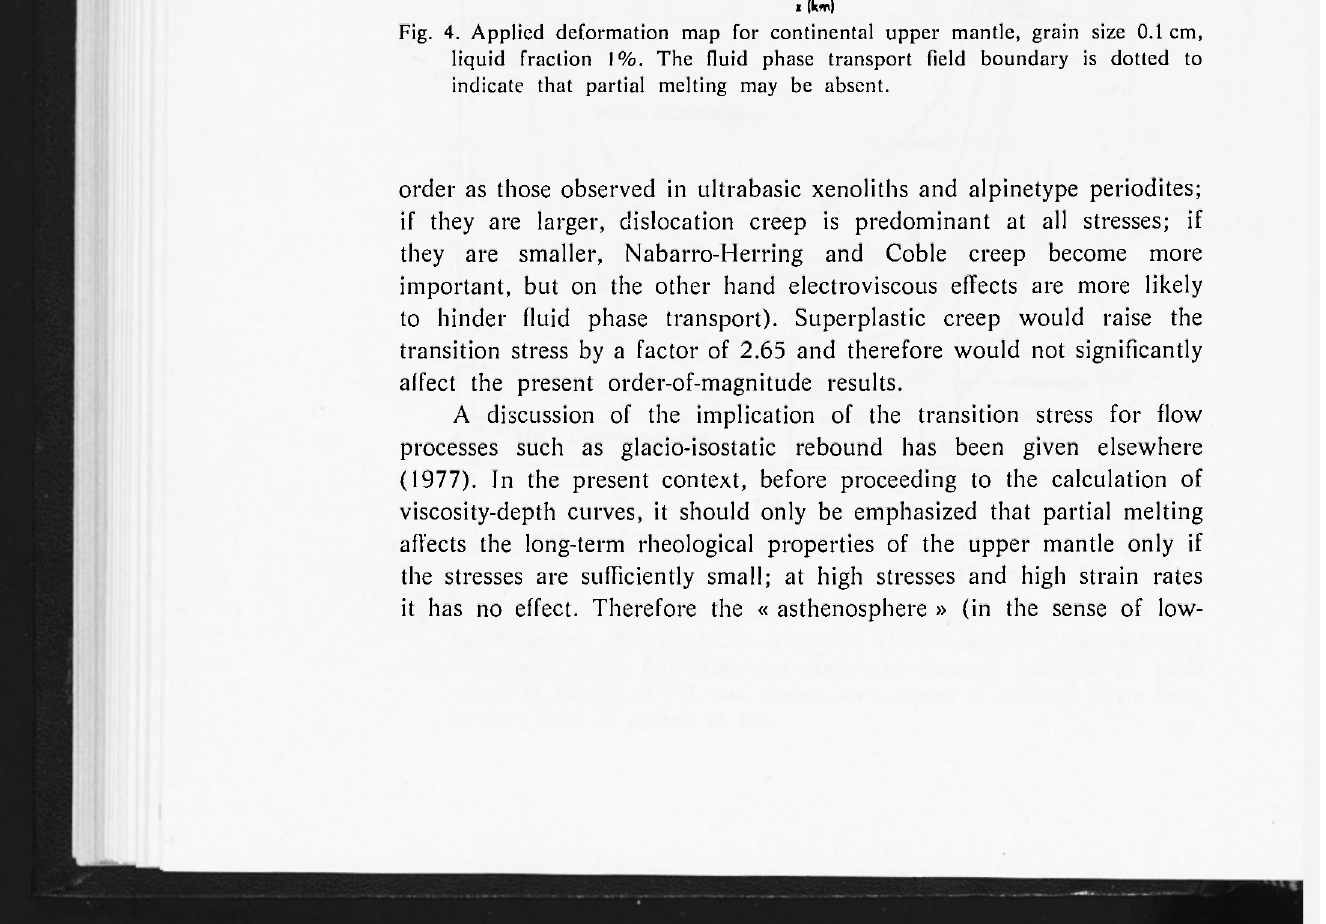
Fig. 4. Applied deformation map for continental upper mantle, grain size 0.1 cm, liquid fraction 1%. The fluid phase transport Held boundary is dotted to indicate that partial melting may be